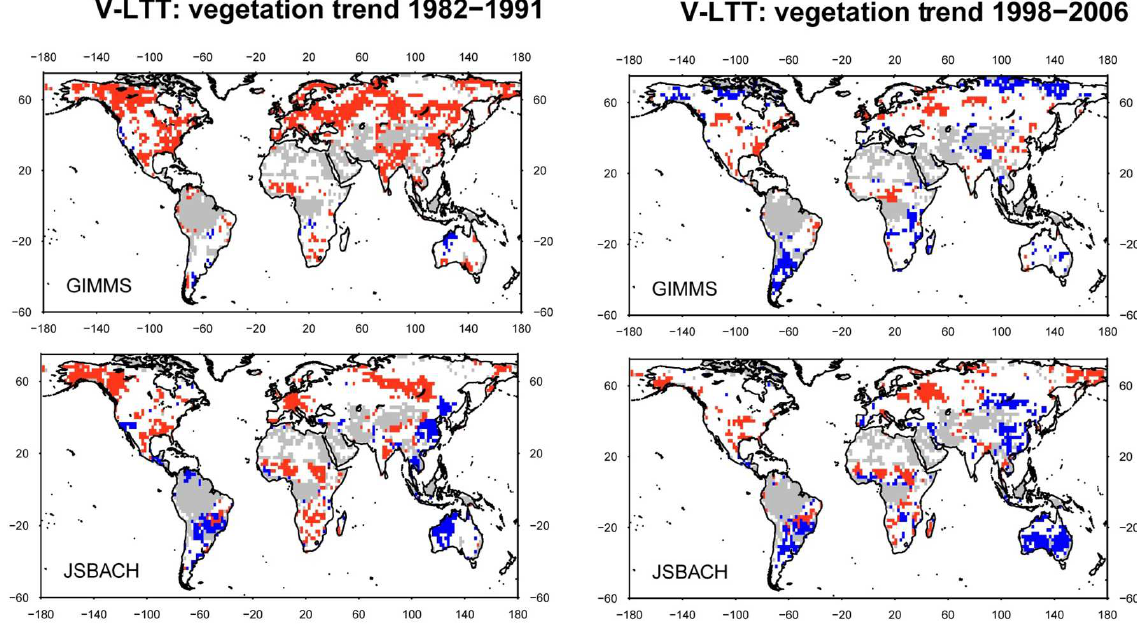
Fig. 7. Vegetation activity trend according to the Mann–Kendall statistics for the period of references is reported for GIMMS-NDVI and modelled FAPAR. Red: positive monotonic trend ( P < 0 . 10); blue: negative monotonic trend ( P < 0 . 1); white: no significant trend; grey: areas masked out from the analysis (grid cells with dominance of tropical forests, dominance of desert and ice).